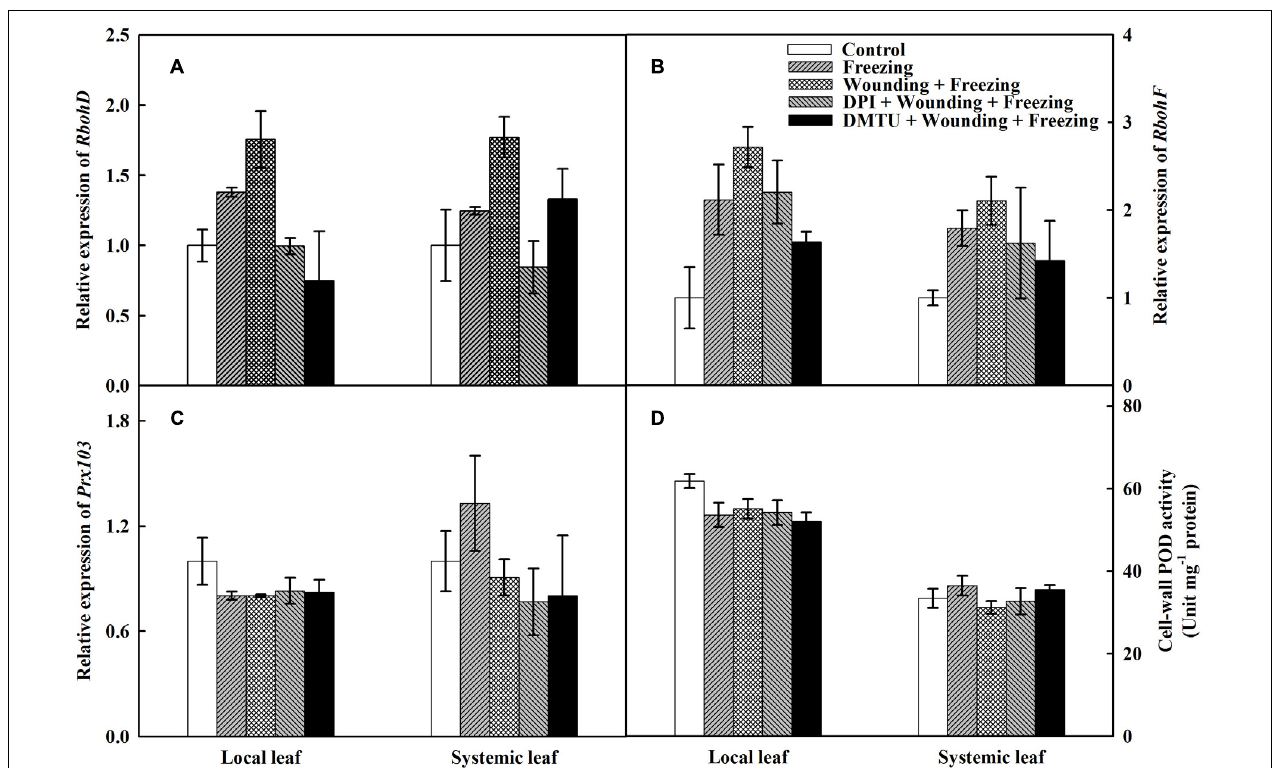
FIGURE 5 | Effects of mechanical wounding on relative transcript abundance of Rbohs , Prx103 and activities of cell-wall POD in the local and the systemic leaves of wheat under freezing stress. Relative transcript abundance of RbohD (A) , RbohF (B) , Prx103 (C) , and activities of cell-wall POD (D) . The local (fifth) leaves were separately pre-treated with distilled water, 5 mM DMTU or 100 µ M DPI prior to wounding. At 10 days after wounding, the seedlings were exposed to freezing stress for 24 h. After 24 h recovery, both local and systemic (sixth) leaves were harvested for the